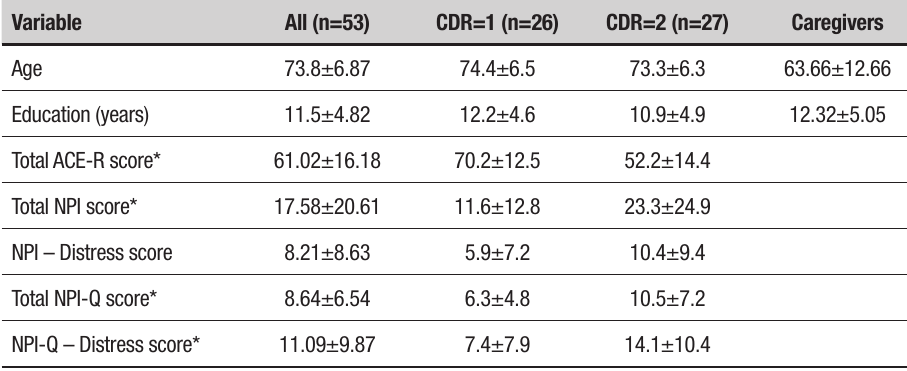
Table 1. Clinical and demographic data.